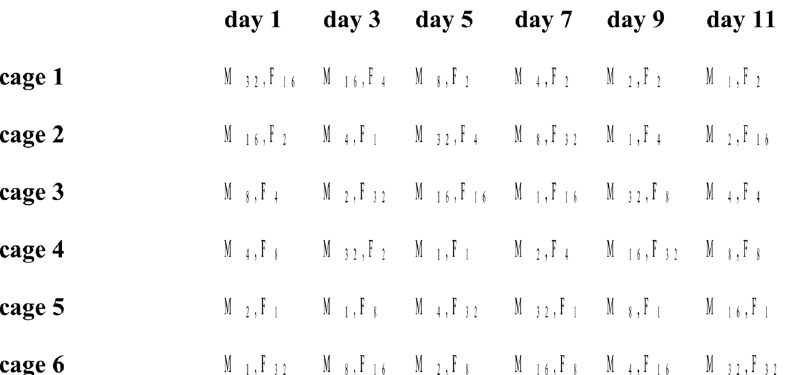
Figure 1. Schematic depiction of the design of the experimental run in which trial duration was ‘long’. Depicted is how, approximating a Graeco-Latin Square, each of the 36 unique combinations of the six levels of male density ‘M’ and female density ‘F’ were laid out over the six levels of the block factors experimental day and cage. The 36 trials of the experimental run in which trial duration was ‘short’ were laid out over the same cages but six other experimental days (days 2, 4, 6, 8, 10 and 12) in a similar manner, although their exact distribution was different.